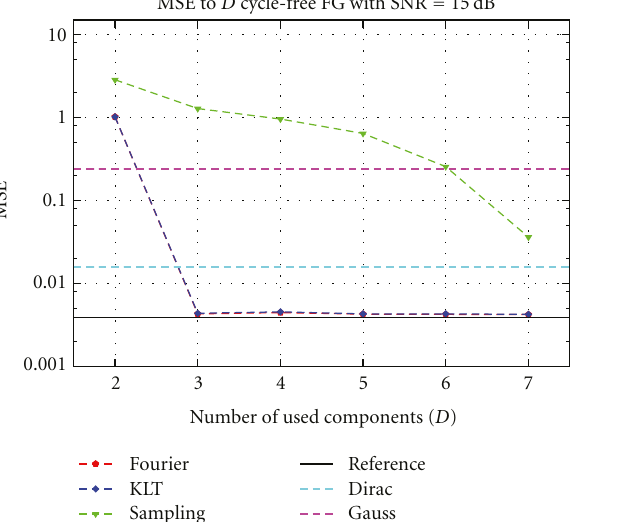
Figure 10: MSE of the phase estimation of the BICM for di ff erent message representations.